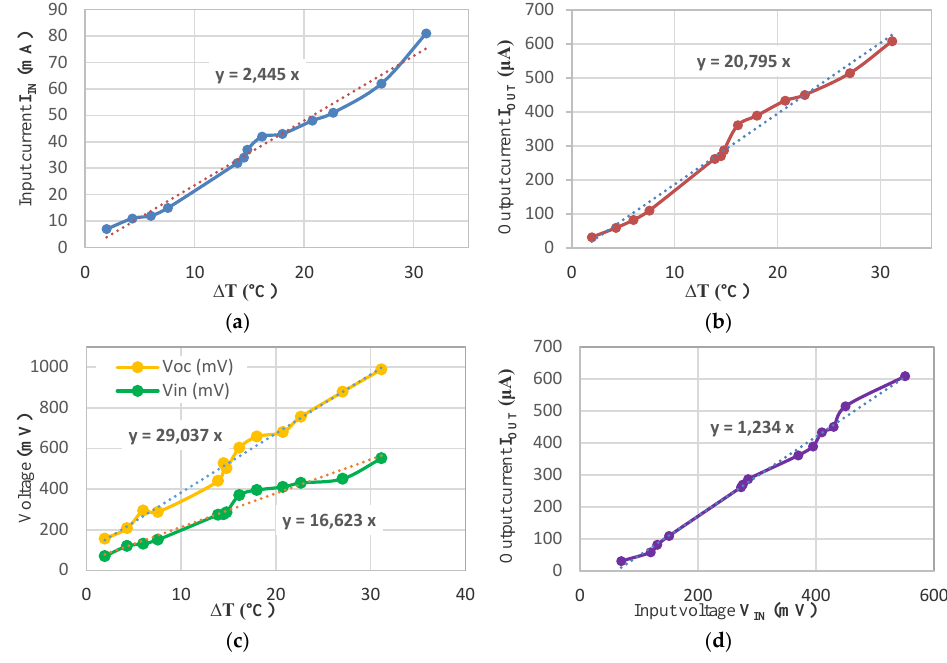
Figure 15. TEC1-12706 TEGs characterization: input current I IN ( a ), output current I OUT ( b ), open-circuit V OC and input V IN voltages ( c ) as function of ΔT, and output current I OUT as function of the input voltage V IN ( d ).